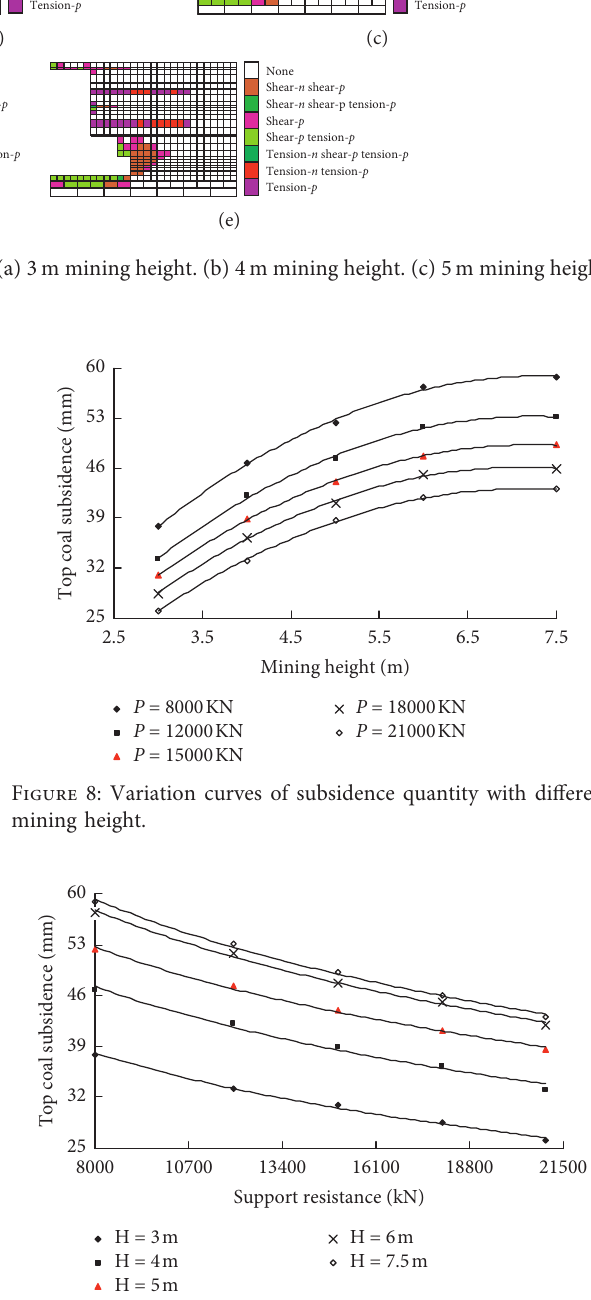
Figure 7: Horizontal displacement of wall with different mining height.